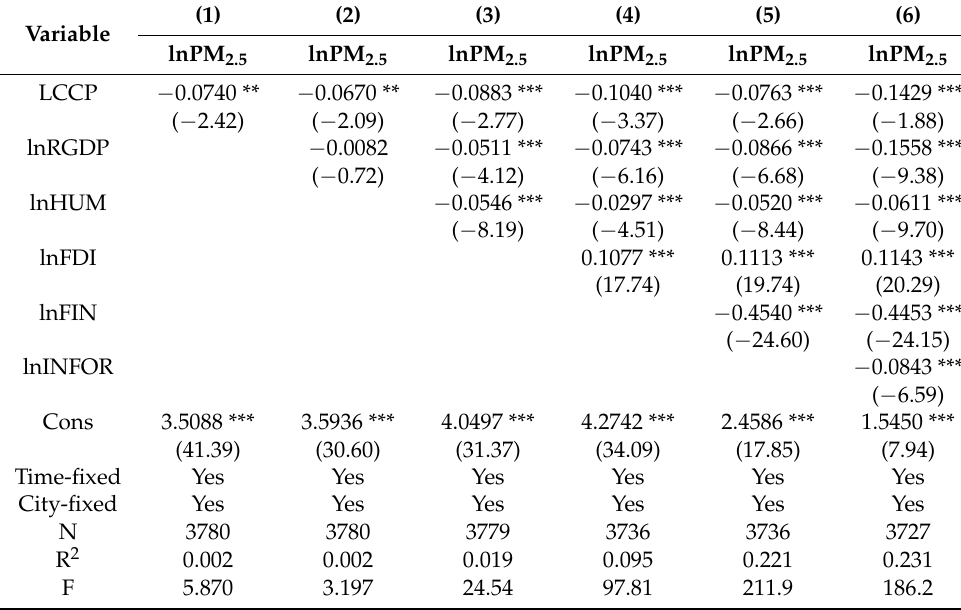
Table 2. Benchmark regression results.